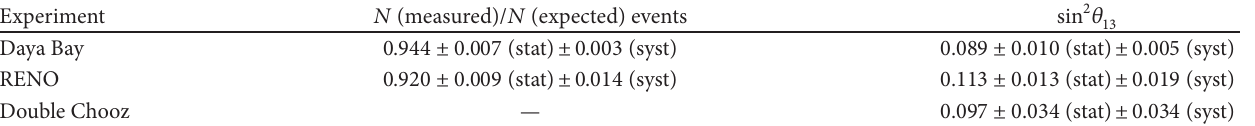
Table 7: Results of the 𝜃 13 measurements from the three experiments detecting the ] 𝑒 from nuclear reactors.